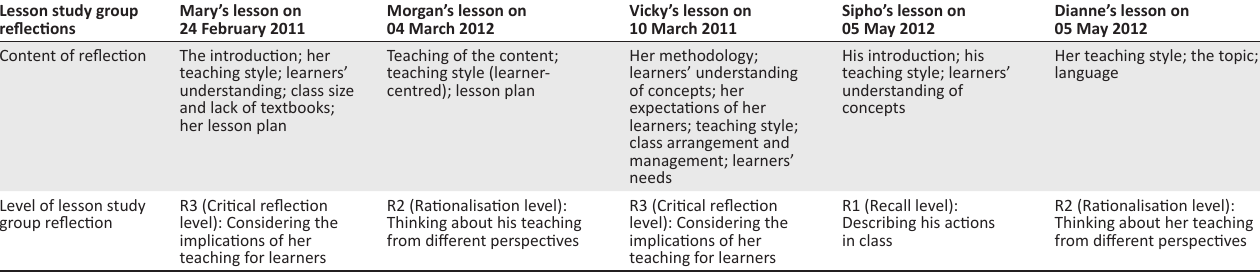
TABLE 3: Summary of content and level of reflection during the lesson study group reflections. Lesson study group